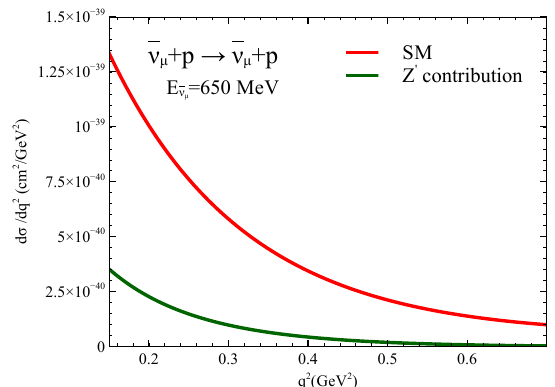
Figure 7 . The SM NC quasi-elastic anti-neutrino-proton cross section, compared to the contribu- tion obtained from our model with the Z 0 due to its couplings to baryons and to ν d . The parameter values used in calculating the Z 0 contributions are the same as those used for our MB result, and are given in table